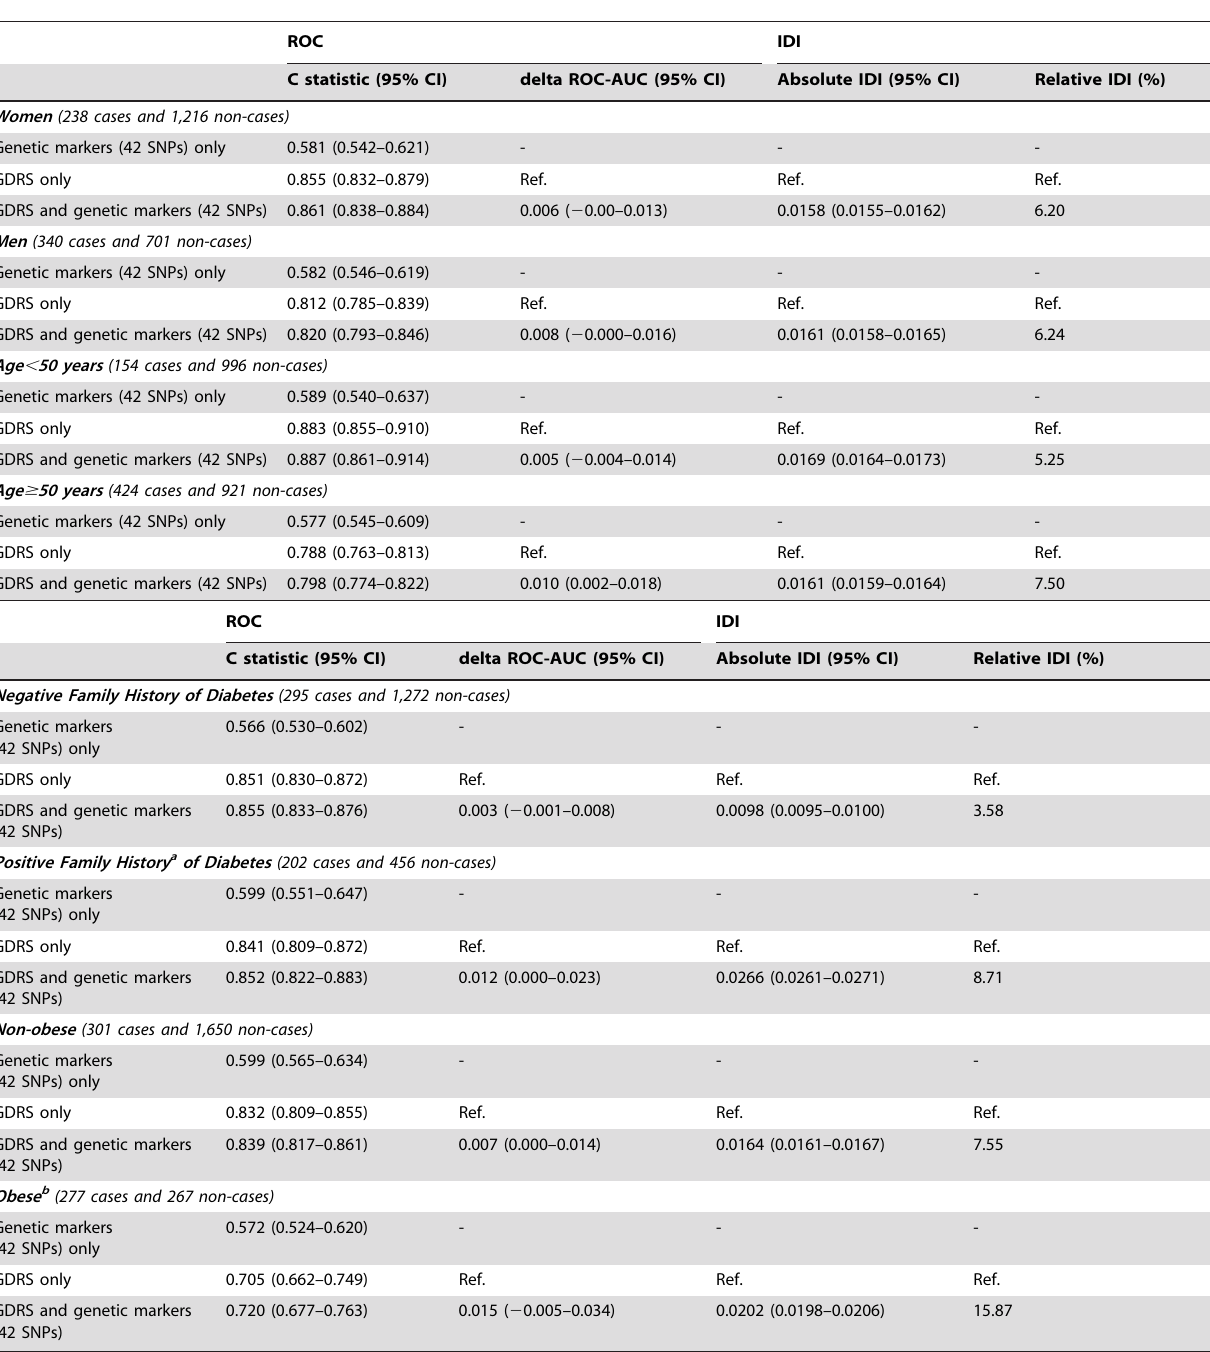
Table 3. Stratified Analyses of the GDRS and GRS with 42 SNPs for Sex, Age, Family History of Diabetes, and Obesity Status.